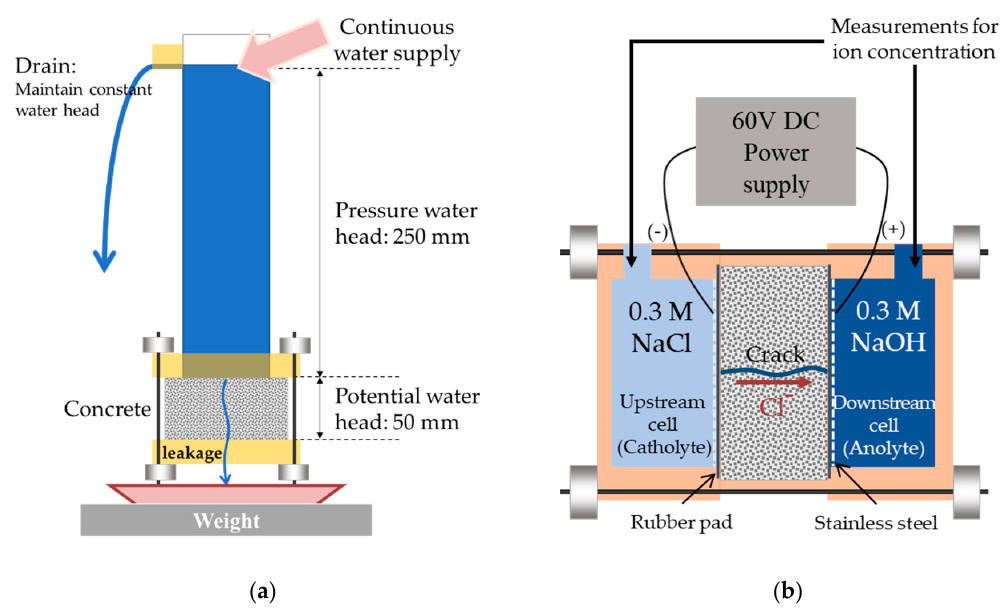
Figure 8. Schematic illustration of water permeability and chloride ion migration test setups: ( a ) Water permeability test; ( b ) Chloride ion migration test.